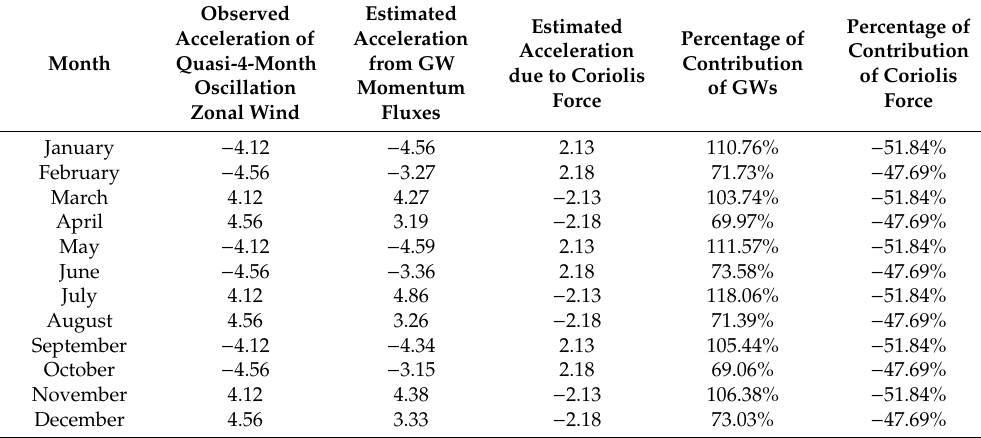
Figure 8. The observed and estimated acceleration for quasi-4-month oscillation zonal winds. Table 2. Percentage of the contribution of GWs and the Coriolis force to the quasi-4-month oscillation zonal wind.